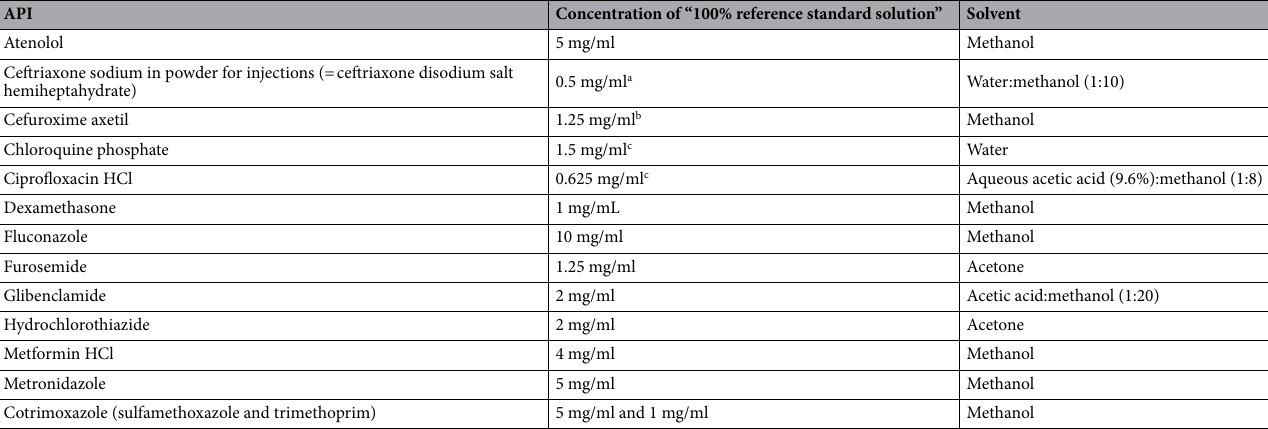
Table 1. Investigated active pharmaceutical ingredients and concentration of their “100% reference standard solutions” according to the GPHF Minilab manual 49 . Following appropriate sample preparation